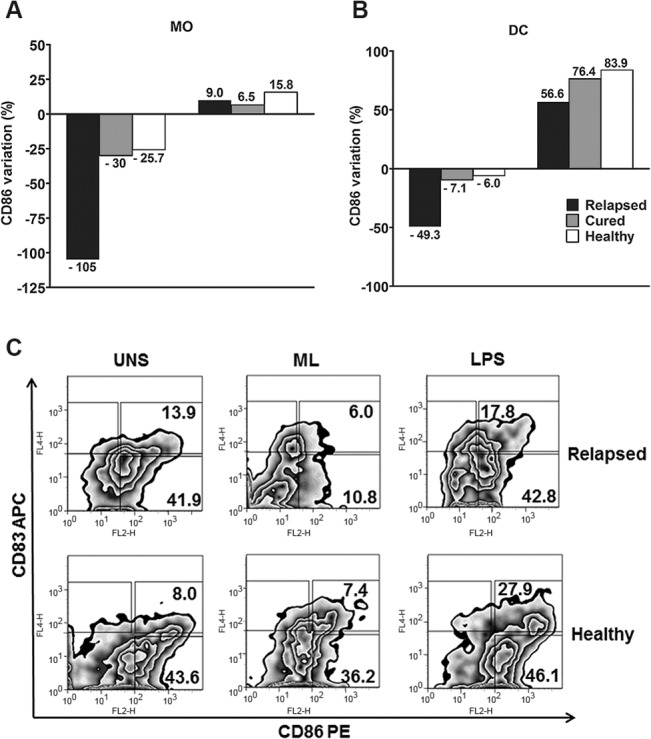
Significant inhibition of CD86 expression in monocytes and DC from MB relapsed leprosy patients.PBMC cultures stimulated with M. leprae (20 μg/mL) and LPS (1 μg/mL) for 24 h were analyzed by flow cytometry (FACSAria, BD). After gating the monocytes and DC region, based on forward and side scatter and the negative region defined with isotype control antibodies for each cell population, CD86 expression was obtained both in monocytes (CD3-/CD83-/CD14+; A) and DC (CD3-/CD14-/CD83+; B). On the left, the bars of both graphics correspond to antigen stimulation, while those on the right correspond to LPS stimulation, in accordance with the assessed groups. The results are expressed as percentage variation, calculated according to the following formula: [CD86 expression in ML-stimulated cultures (%) / CD86 expression in unstimulated cultures (%) × 100] −100; C). A representative example of the flow cytometric determination of CD86 expression in unstimulated (UNS), M. leprae stimulated (ML), and LPS stimulated monocytes, and DC from a relapsed patient (upper dot plots) and a healthy volunteer (lower dot plots). The numbers inside the dot plots represent the percentage of CD86 positive cells in monocytes (CD83-; lower right panels) and DC (CD83+; upper right panels).